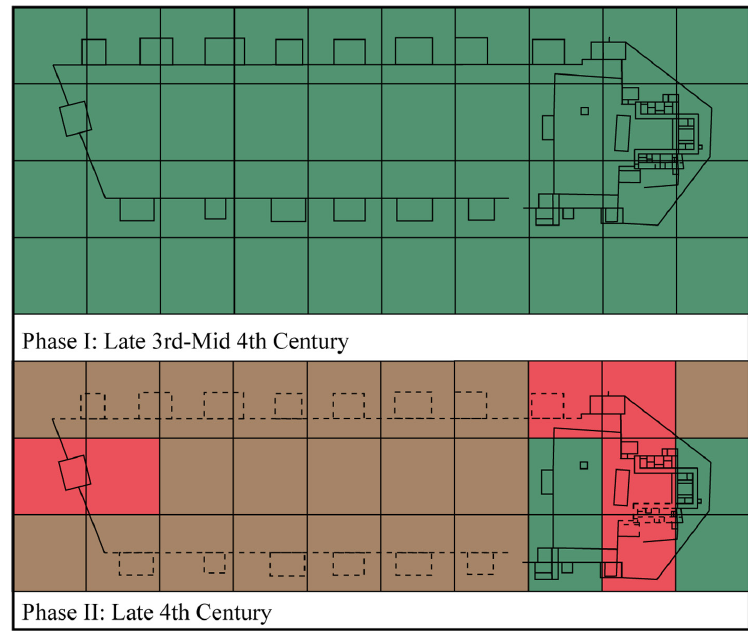
Figure 7: A macro-level view of different activity types at Borg (laid out in a 40 × 40 grid) highlighting continued occupation (green), transformation (red), unknown areas (brown), and areas with no information